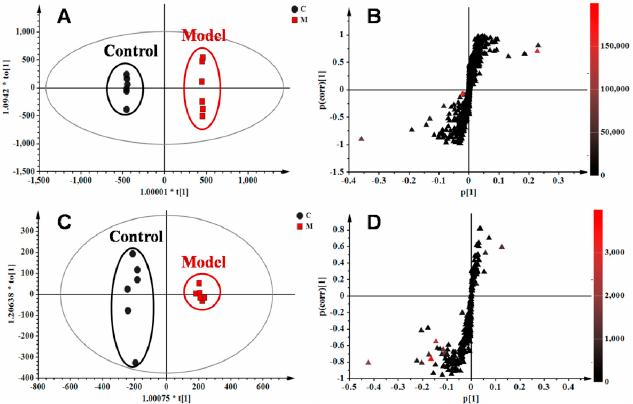
Figure 4. OPLS − DA score plots and S -plots based on lung tissue of the control and model groups in ( A , B ) R 2 X = 0.554, R 2 Y = 1.000, Q 2 (cum) = 0.907) positive and ( C , D ) R 2 X = 0.558, R 2 Y = 0.990, Q 2 (cum) = 0.953) negative ion modes.